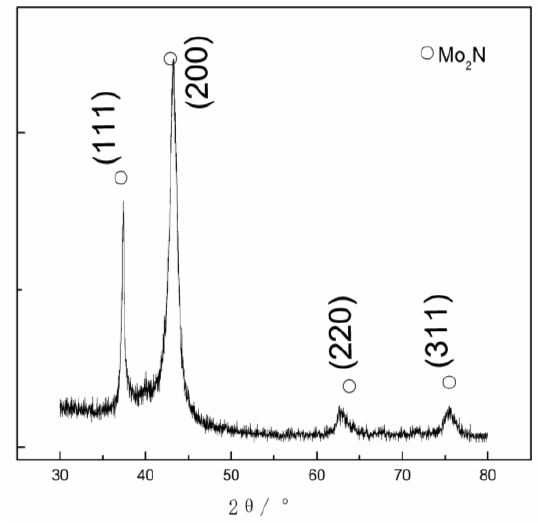
Figure 2. XRD pattern of binary Mo 2 N film.